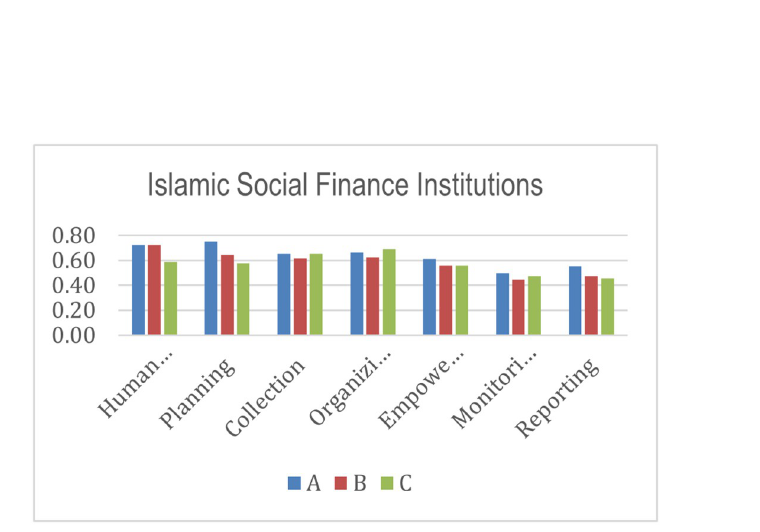
Fig 4. Index score of Islamic Social Finance